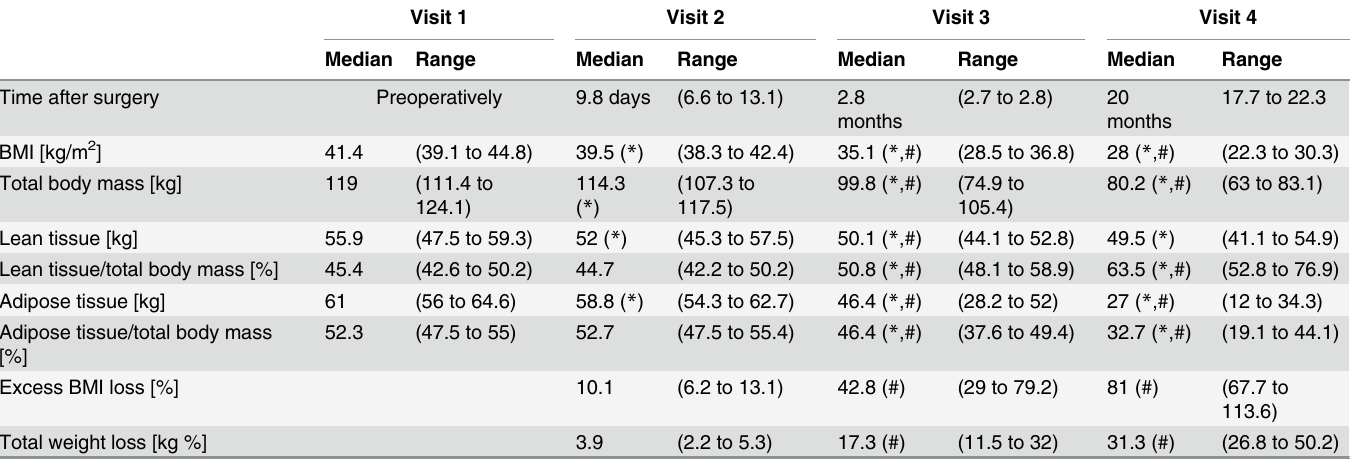
Table 1. Body composition in six females before and after gastric bypass